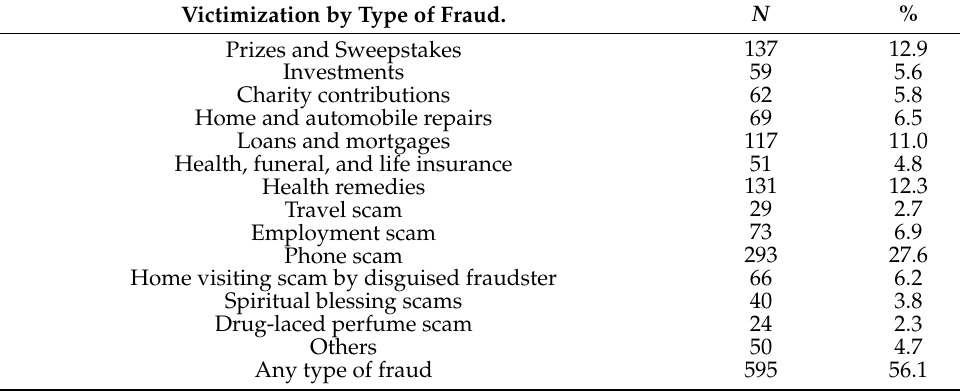
Table 2. Number and percentage of victims by type of fraud ( N = 1061). Victimization by Type of